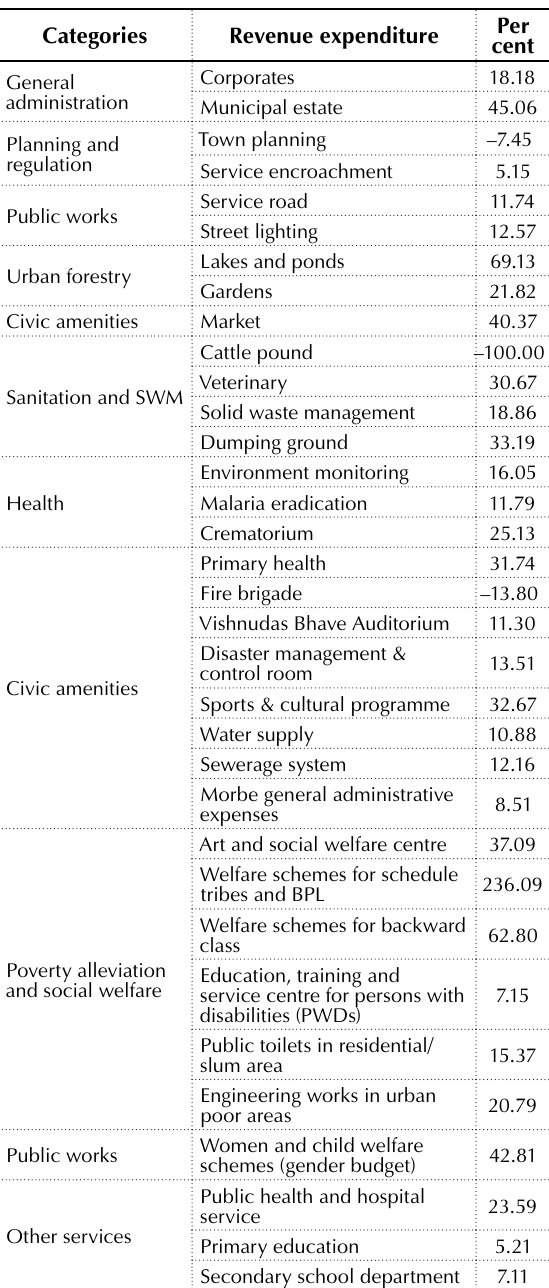
Table 3. The revenue expenditure of Navi Mumbai Municipal Corporation